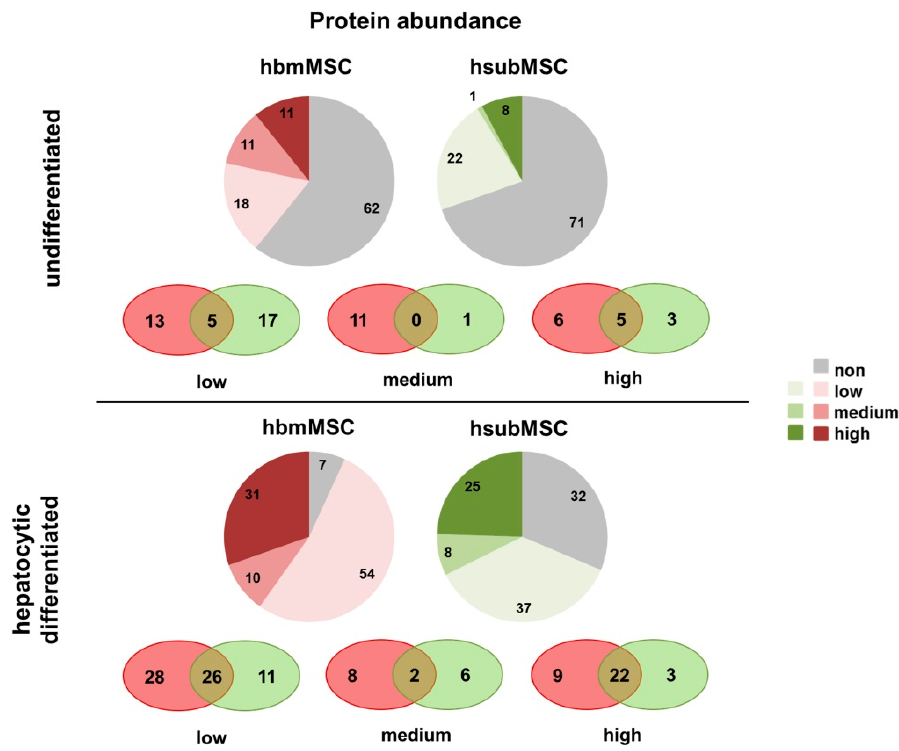
Figure 3. Graphical illustration of proteins secreted by undifferentiated ( top ) and differentiated ( bottom ) hbmMSC ( red ) and hsubMSC ( green ). The pie charts represent the number of proteins arbitrarily classified as low, medium and high secretion. The number of proteins not detected is shown in grey. Proteins secreted both by hbmMSC and hsubMSC are shown as the intersection of proteins secreted at low, medium and high abundance. Estimates were deduced from three independent experiments using MSC from three different donors each.